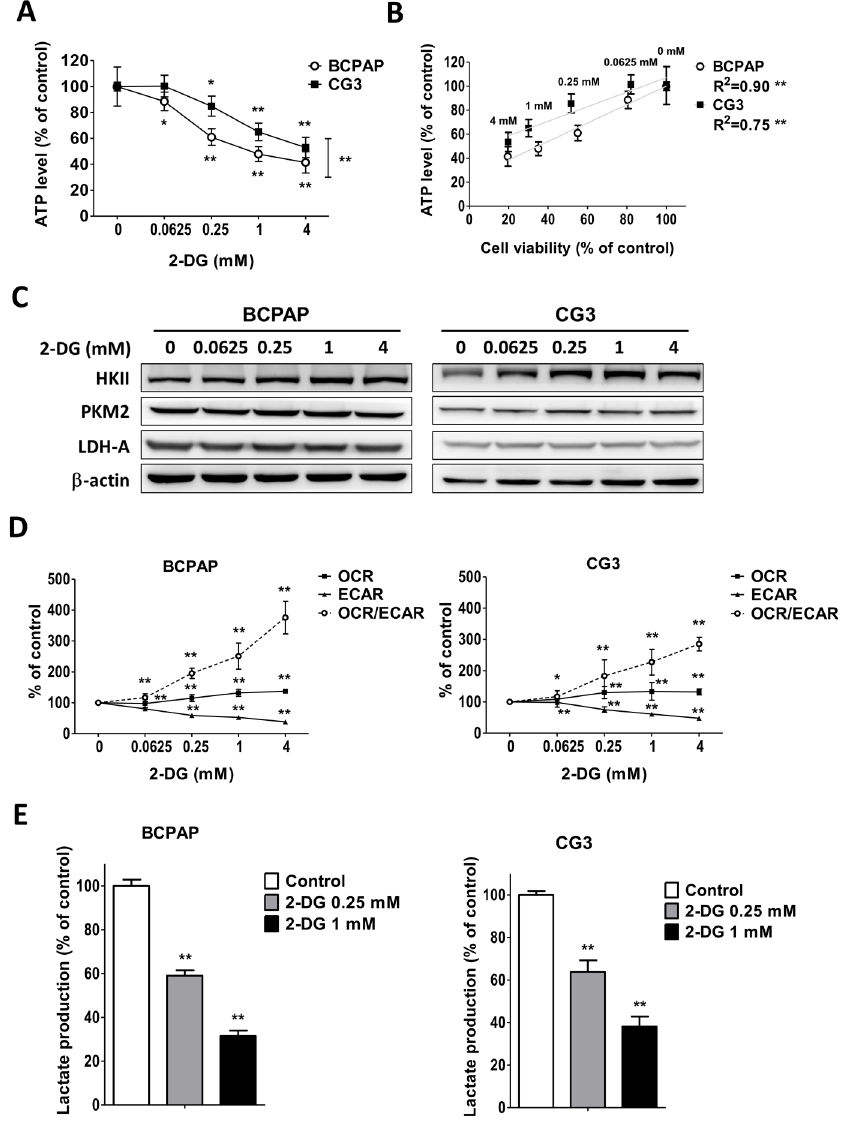
Fig 3. Effects of 2-DG on the changes in bioenergetics of PTC cells. (A) Intracellular ATP levels in cells treated for 48 h with different concentrations of 2-DG. Data are shown as a percentage of the controls (untreated) cells after normalization to total cellular protein in each well. * p < 0.05, ** p < 0.001, compared to the controls ( t test); ## p < 0.001, comparison of the two groups in a two-way analysis of variance (ANOVA). (B) Relationship between cell viability and intracellular ATP depletion. * p < 0.05, ** p < 0.001, analyzed using linear regression. (C) Expression of hexokinase II (HKII), the M2 isoform of pyruvate kinase (PKM2), and lactate dehydrogenase-A (LDH-A) protein in BCPAP and CG3 cells treated for 48 h with 0, 0.0625, 0.25, 1, and 4 mM 2-DG. (D) OCR, ECAR, and OCR/ECAR in BCPAP and CG3 cells treated for 3 h with different concentrations of 2-DG. The changes were normalized to 1 μ g cellular protein and are presented as a percentage of the control values. (E) Extracellular L -lactate production in BCPAP and CG3 cells treated for 48 h with 0, 0.25, and 1 mM 2-DG. C-E: * p < 0.05, ** p < 0.001, compared to the controls ( t test). Data are presented as means ± standard deviation